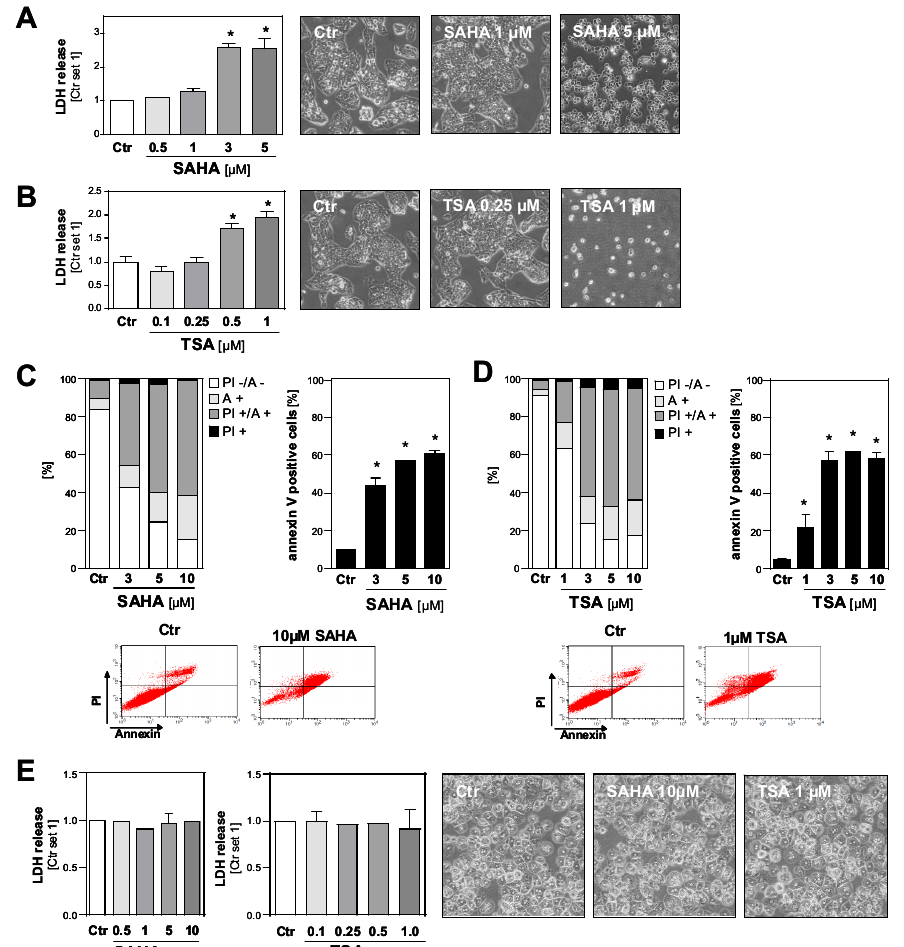
Figure 5. Effects of HDAC inhibition on the viability of HCC cells and primary hepatocytes. ( A , B ) Lactate dehydrogenase (LDH) release into the supernatant (left panel) and representative light microscopical images (right panels) of human HCC cells (HepG2) after 72 h treatment with different doses of SAHA (A) or TSA (B). Control cells (Ctr.) treated with solvent (DMSO) only were set as 1. ( C , D ) Propidium iodide/annexin (PI/A) FACS analysis of HepG2 cells after 24 h treatment with SAHA (C) or TSA (D). Left panel: proportions of viable (PI -/ A-), early (A +) and late apoptotic (PI +/ A+) and necrotic cells (PI +); right panel: quantification of annexin-positive late apoptotic cells; lower panel: representative FACS images. ( E ) LDH release into the supernatant (left panels) and light microscopical images (right panels) of primary human hepatocytes treated with different doses of SAHA or TSA for 72 h. Control cells (Ctr.) treated with solvent (DMSO) only were set at a value of 1. (*: p < 0.05 compared to Ctr.).